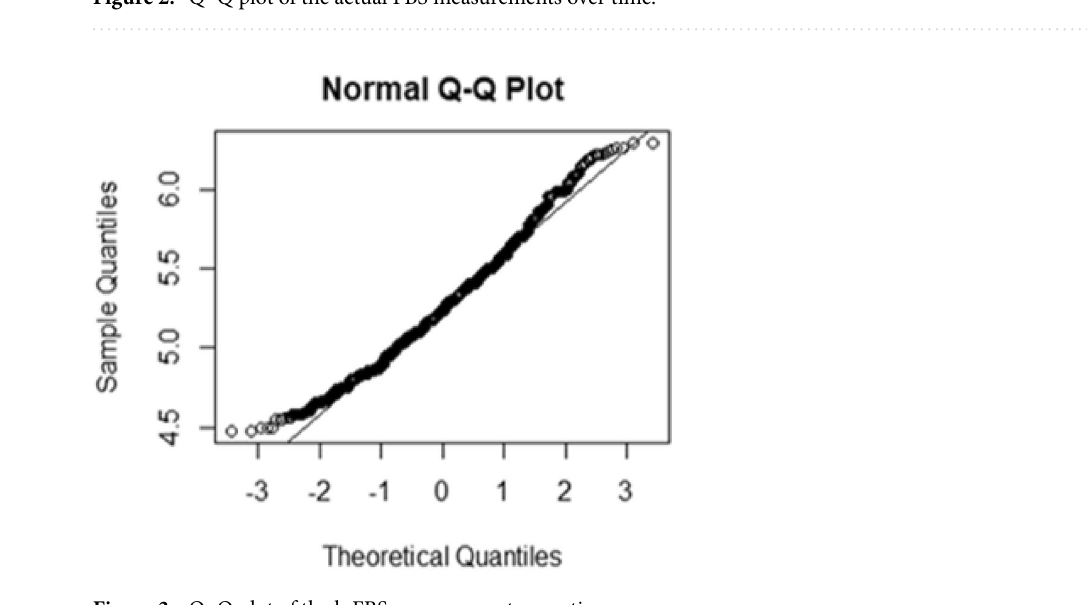
Figure 2. Q–Q plot of the actual FBS measurements over time.